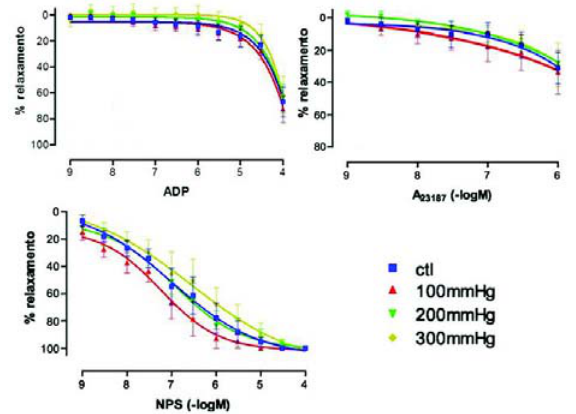
Fig. 6 - Curva dose-resposta a concentrações crescentes de adenosina difosfato (relaxamento dependente de receptor), ionóforo do cálcio (relaxamento independente de recepto) e nitroprussiato de sódio (relaxamento independente do endotélio) - (n=6, ANOVA,